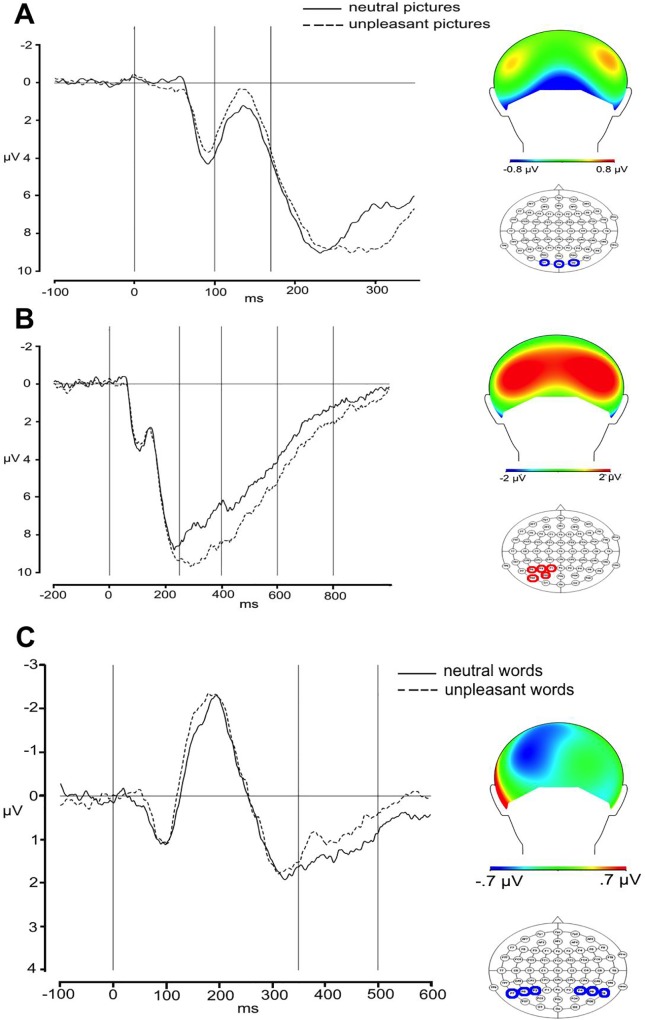
Effect of emotion for pictures.Grand average waveforms for relevant sites and topographical distribution of the emotional effect (negative minus neutral) for pictures (A, B) and words (C). In each figure, the first vertical line in the plot of grand averages indicates the target onset, and the following vertical lines the boundaries of the time windows of analyses.